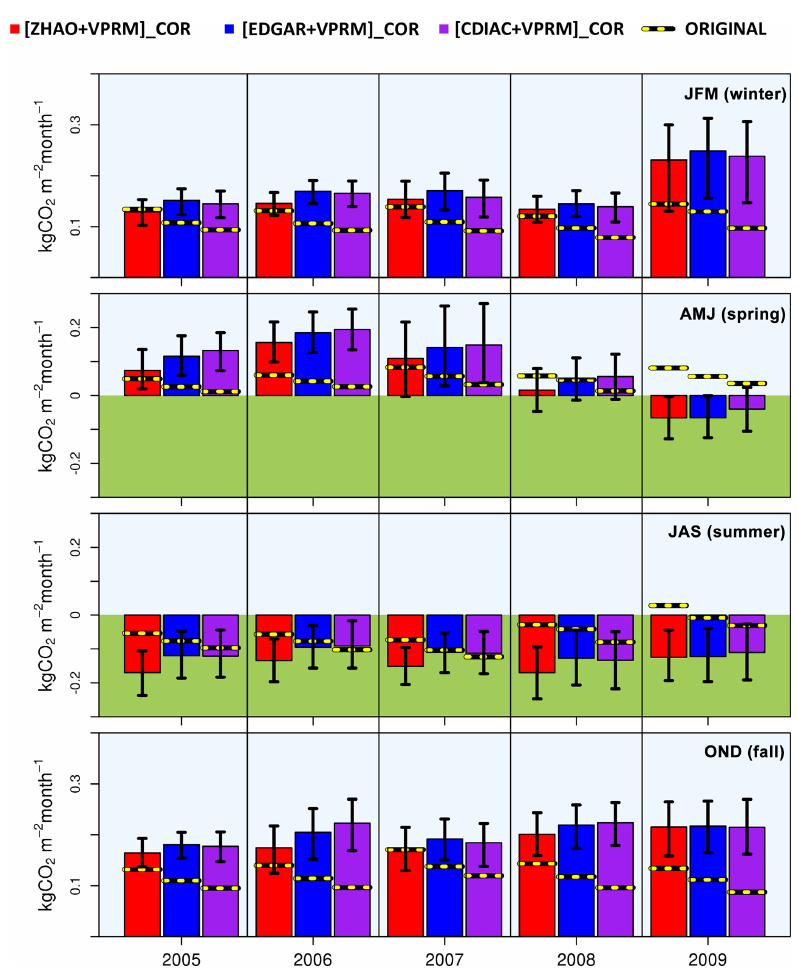
Figure 7. Scaled seasonal fluxes in the L_0.90 region (kgCO 2 m − 2 per month). Anthropogenic and vegetation inventories are scaled together ([ANTH + VPRM_COR]). The black and yellow dashed line is the seasonal flux estimated by the original ANTH + VPRM model. All models have the same vegetation component (VPRM) and differ only in the anthropogenic inventory source. Shaded green represents negative flux (uptake by biosphere). The scaling based on additive corrections; the difference among scaled inventories is due to differing spatial allocations by anthropogenic inventories. Bootstrapped 95% confidence intervals are represented by the black vertical lines.